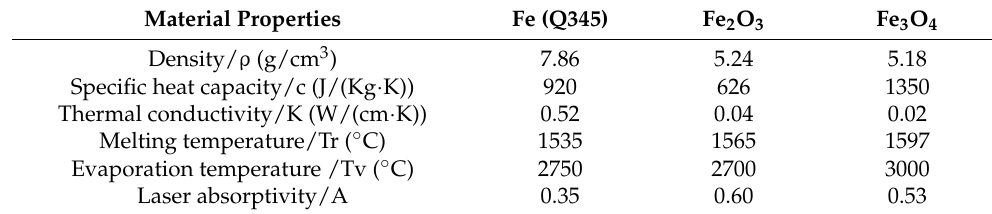
Table 1. Material properties of each